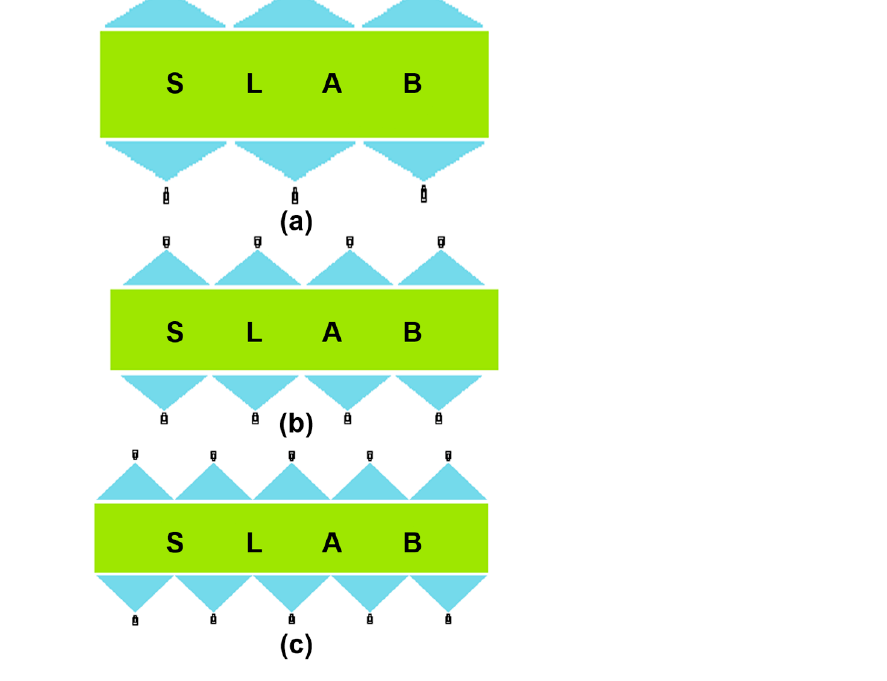
Figure 6. ( a – c ) Different arrangements of slab cooling sprays in continuous casting machines.